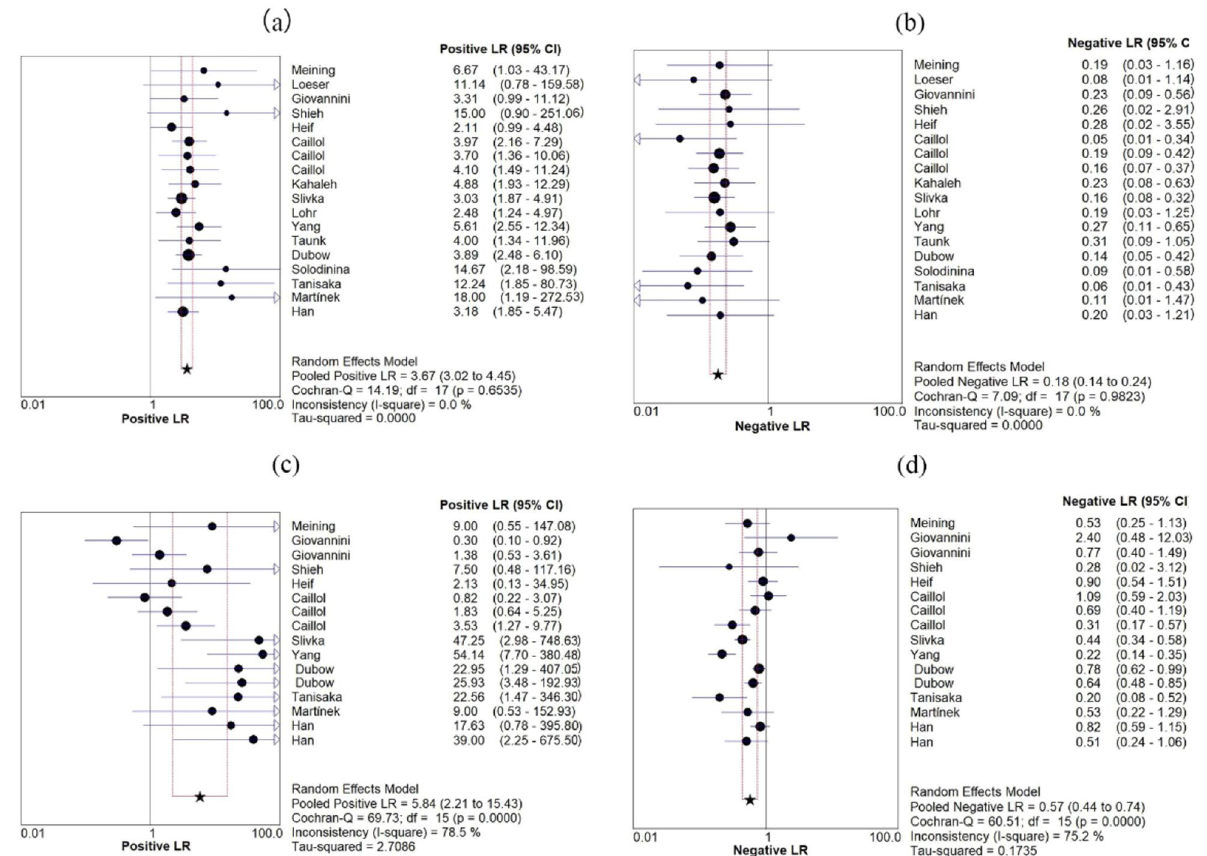
Figure 4. Forest plot of PLR and NLR of pCLE ( a , b ) and tissue sampling by ERCP ( c , d ) in diagnosing indeterminate biliary